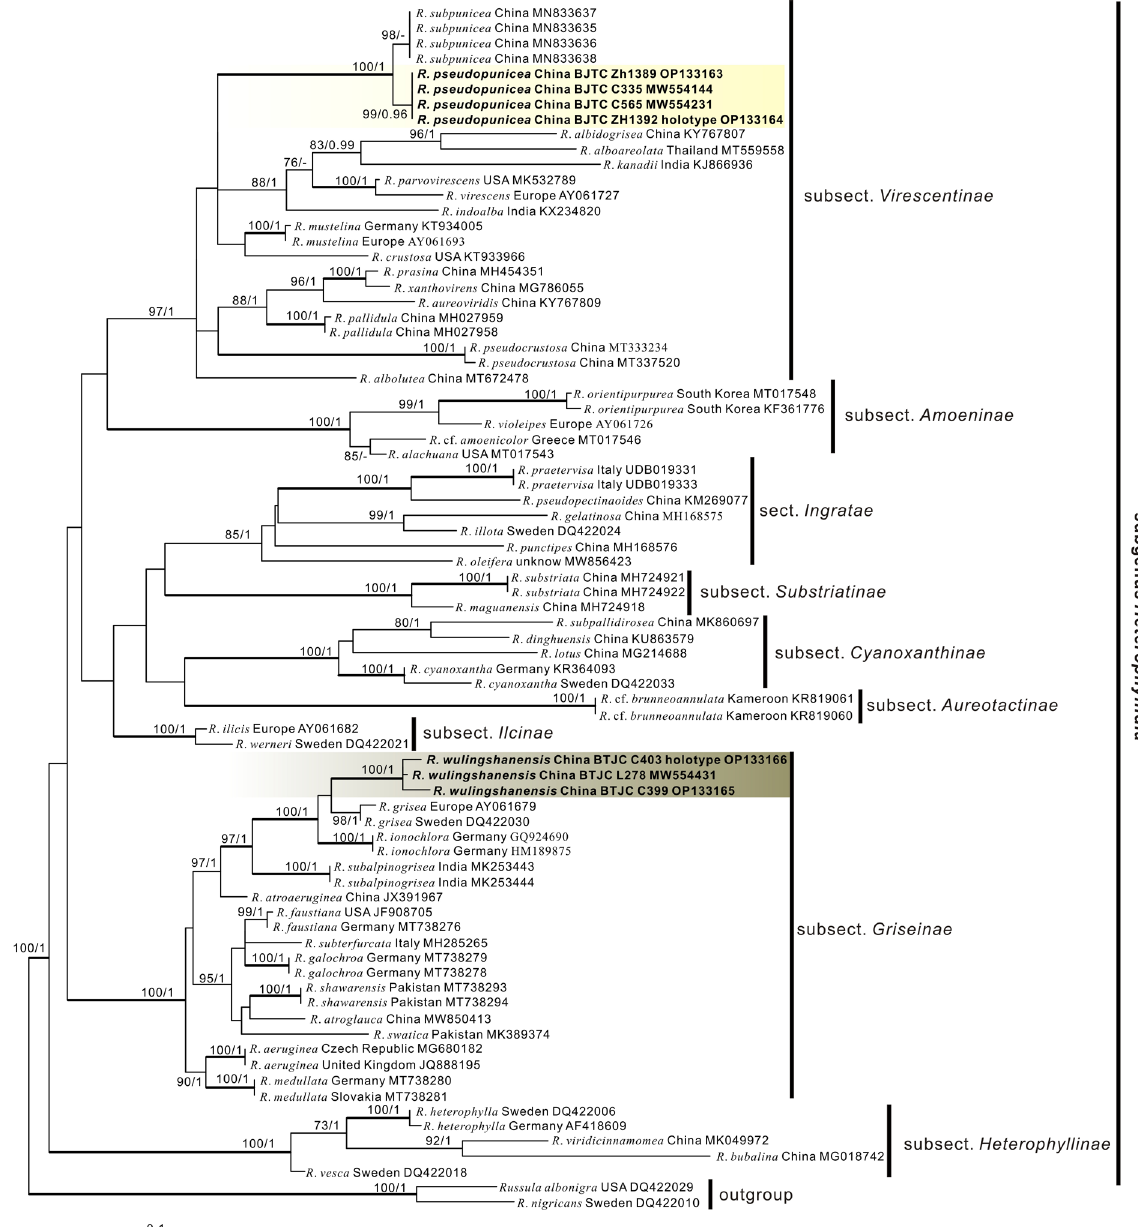
Fig. 2. Maximum likelihood (ML) phylogenetic tree inferred from nrITS. The two new species described in this paper are indicated in bold . Values next to nodes indicate ML bootstrap values (left) and Bayesian posterior probabilities (right). Only ML bootstrap values ≥ 70% and Bayesian posterior probabilities ≥ 0.95 are